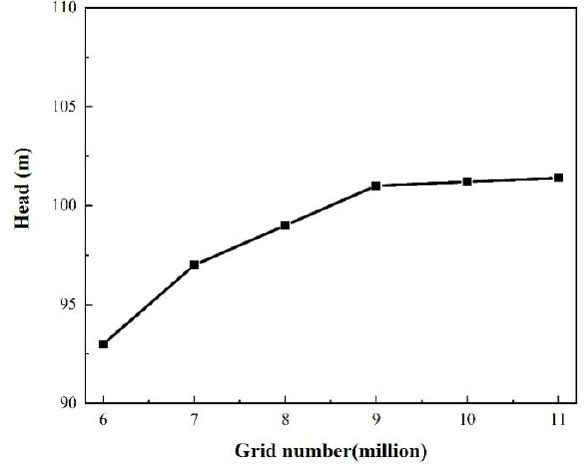
Figure 5. The head curve as a function of the number of grid elements.